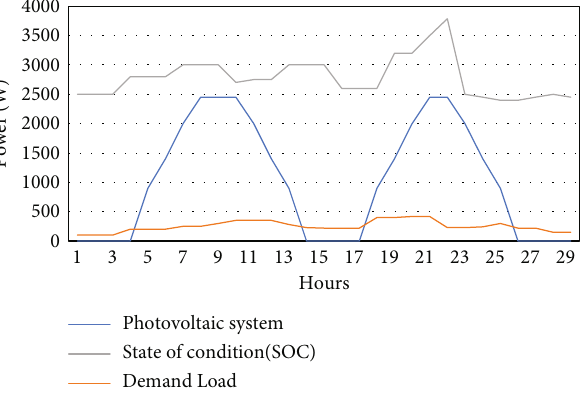
Figure 11: Three days in the month of April.